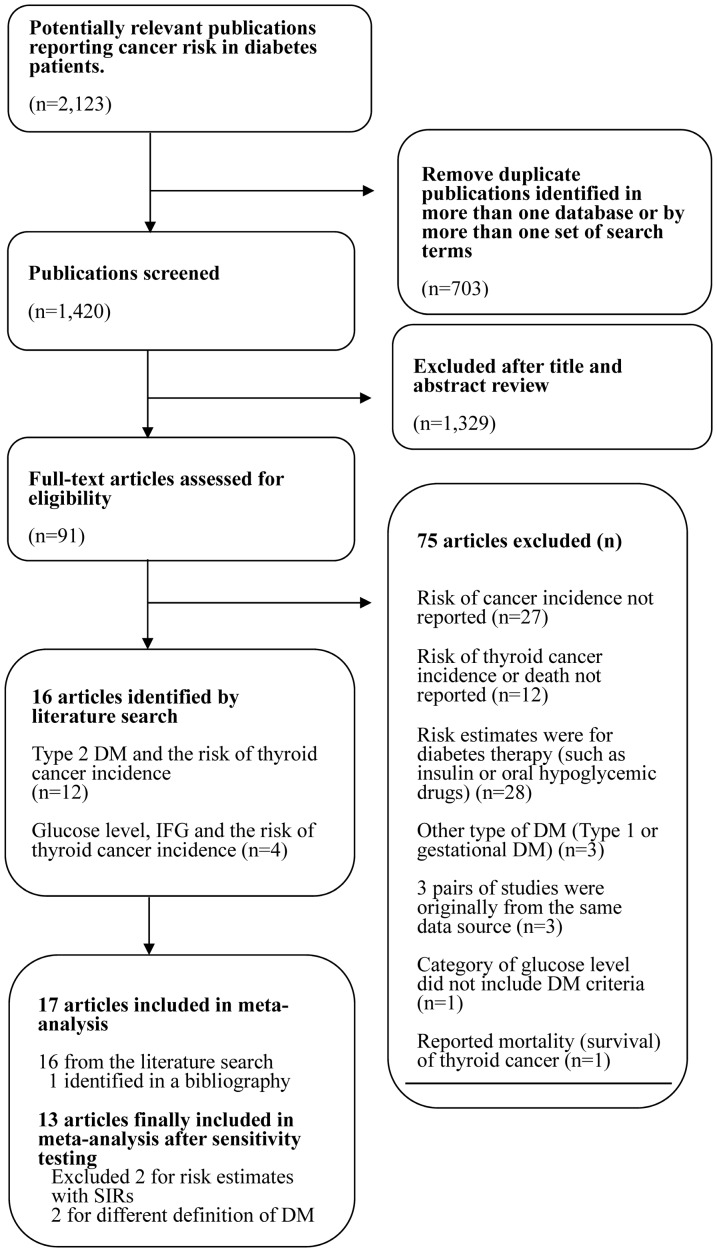
Literature search algorithm.